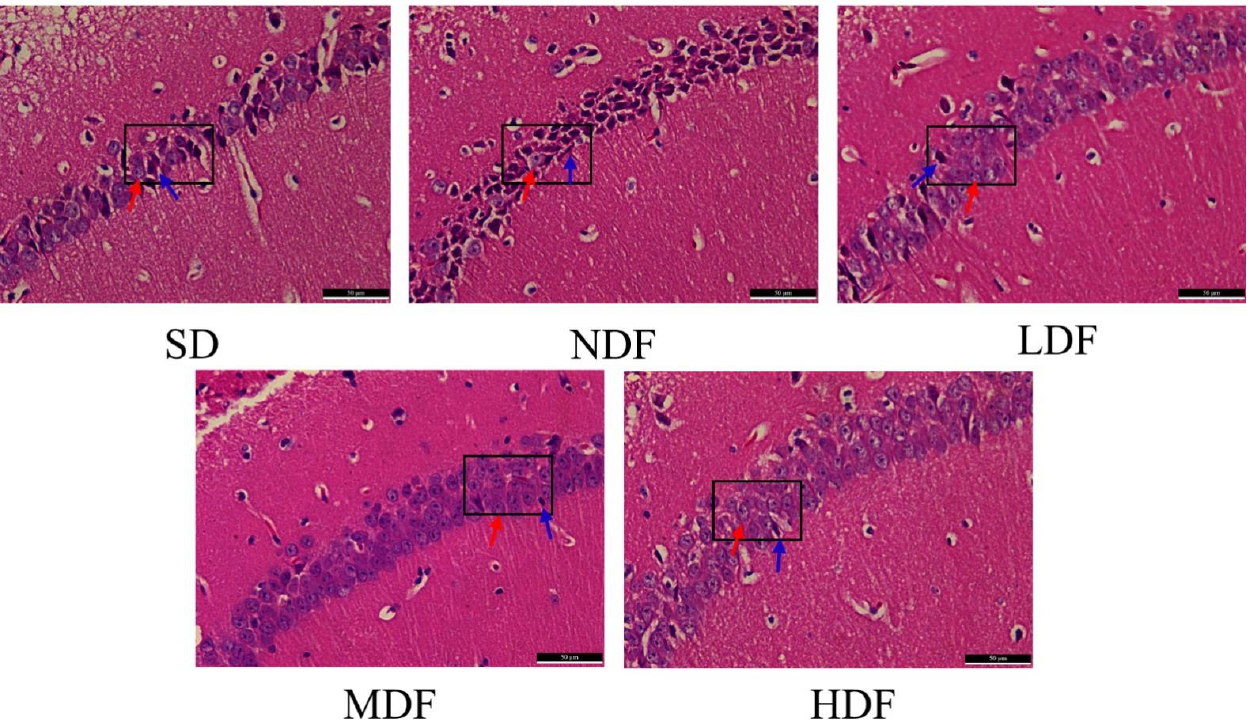
Figure 5. Representative images of HE staining in the brain (magnification, 400×); red arrows indi- cate normal cells, blue arrows indicate crinkled